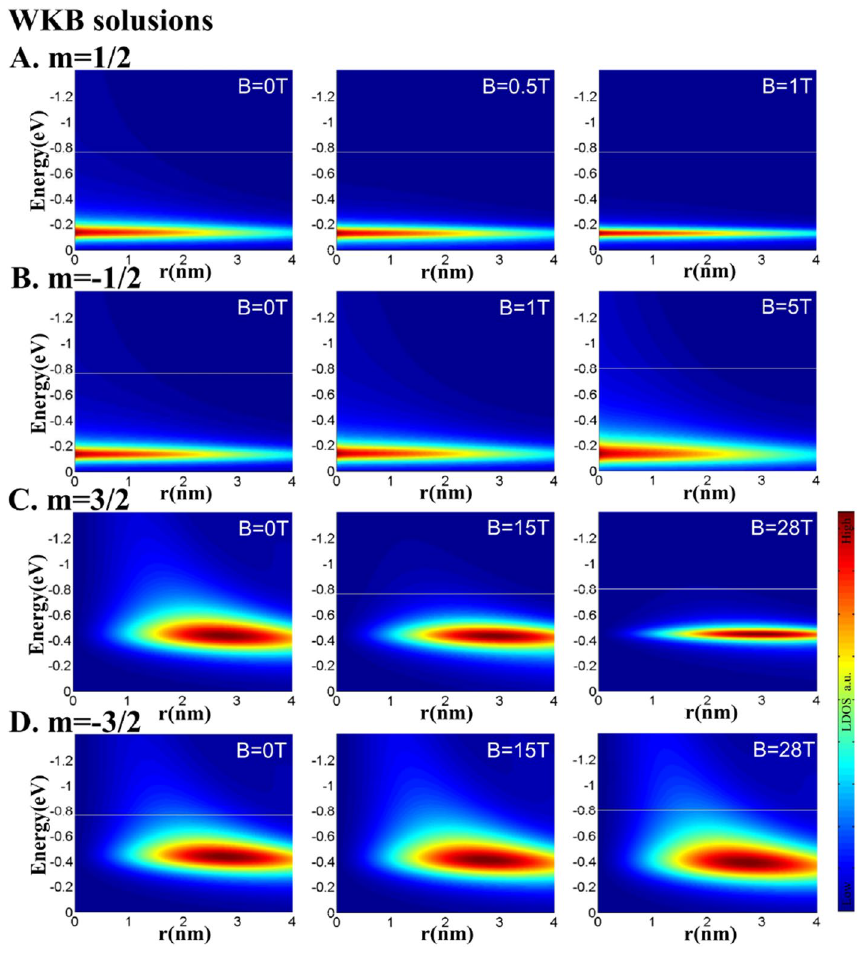
Figure 4. Evolution of LDOS for different angular momenta. Increasing the magnetic field breaks the energy- level degeneracy of the NPN-type graphene quantum dot. Rows (A)–(D) show the three-dimensional LDOS 4 nm , V 0 0.42 eV , and E 0.09 eV under different magnetic maps of the graphene quantum dot with R D = − = = 1 / 2, B 0, 0.5, 1T ( B c 1.1T ) , ( B ) m 1 / 2, B 0, 1, 5T ( no B field strengths: ( A ) m m 1 / 2 1 / 2 ), c | m = = | ≈ = − = ) . When = =− 3 / 2, B 0, 15, 28T ( B c 28.2T ) , and (D) m 3 / 2, B 0, 15, 28T ( no B ( C ) m m 3 / 2 3 / 2 c | m = = | ≈ = − = = =− m > 0 , the energy level shifts in the negative direction and becomes narrower; when m > 0 , it moves in the positive direction and